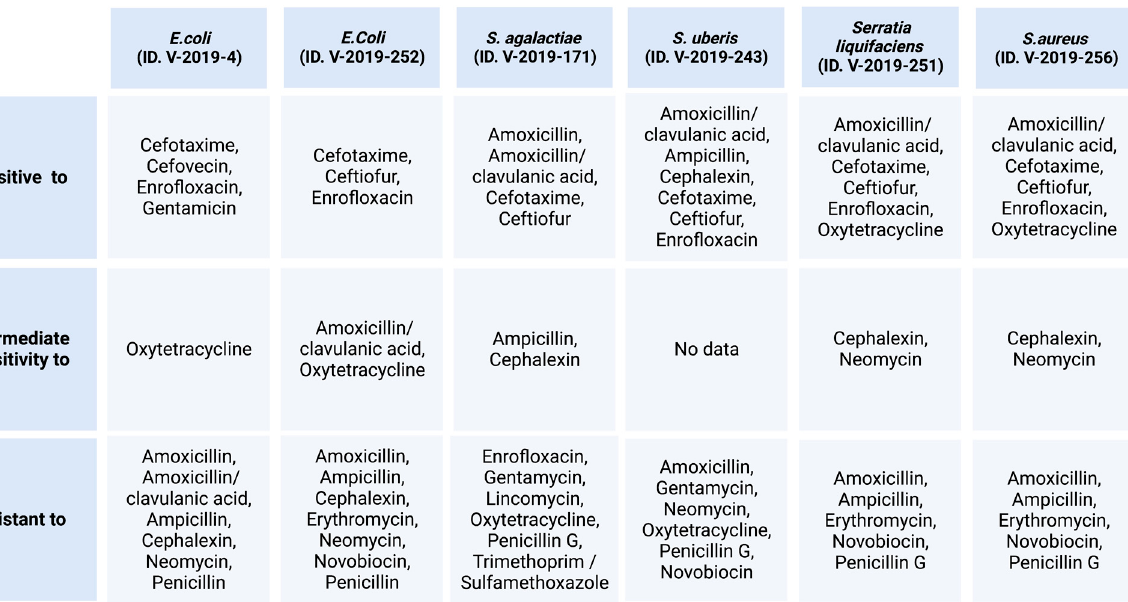
Figure 2. Extract preparation process.